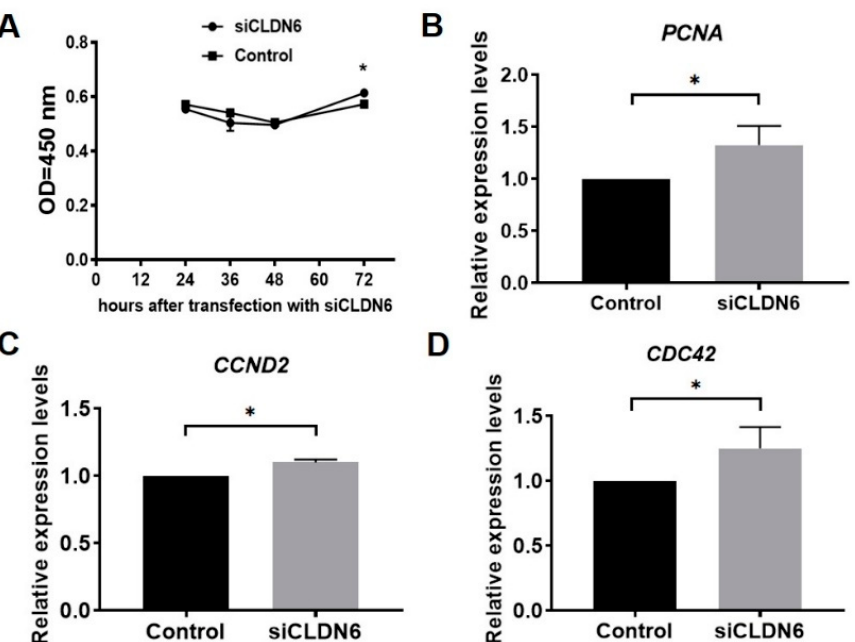
Figure 5. Proliferation analysis of bovine CCs with CLDN6 knockdown. ( A ) After transfection with siCLDN6 or siNC, CCs were treated with CCK-8 and the absorbance at 450 nm was detected. * refers to significant difference ( p < 0.05). ( B – D ) The mRNA levels of PCNA , CCND2 and CDC42 genes were measured in CCs transfected with siCLDN6 or siNC by RT-qPCR, respectively. Control group was the cells transfected with siNC. * p <